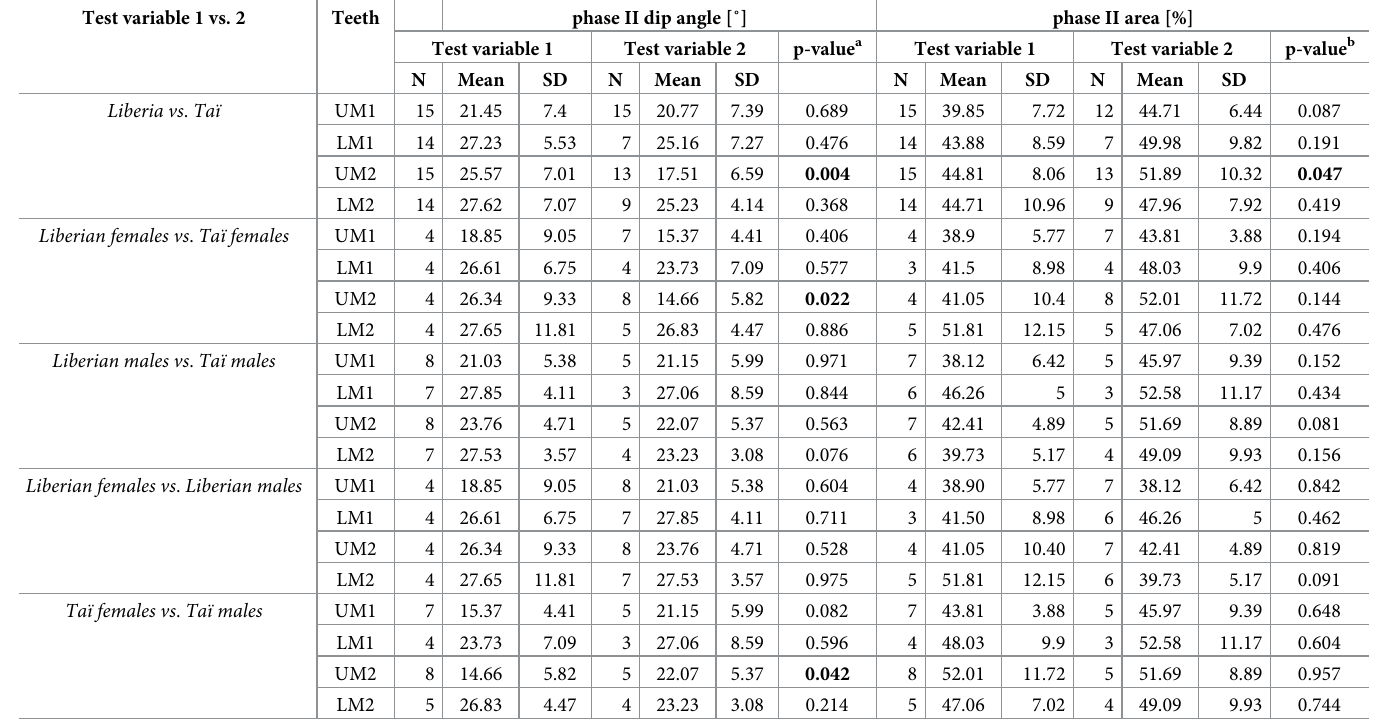
Table 1. Descriptive statistics for dip angles and areas for phase II wear facets. Test variable 1 vs.